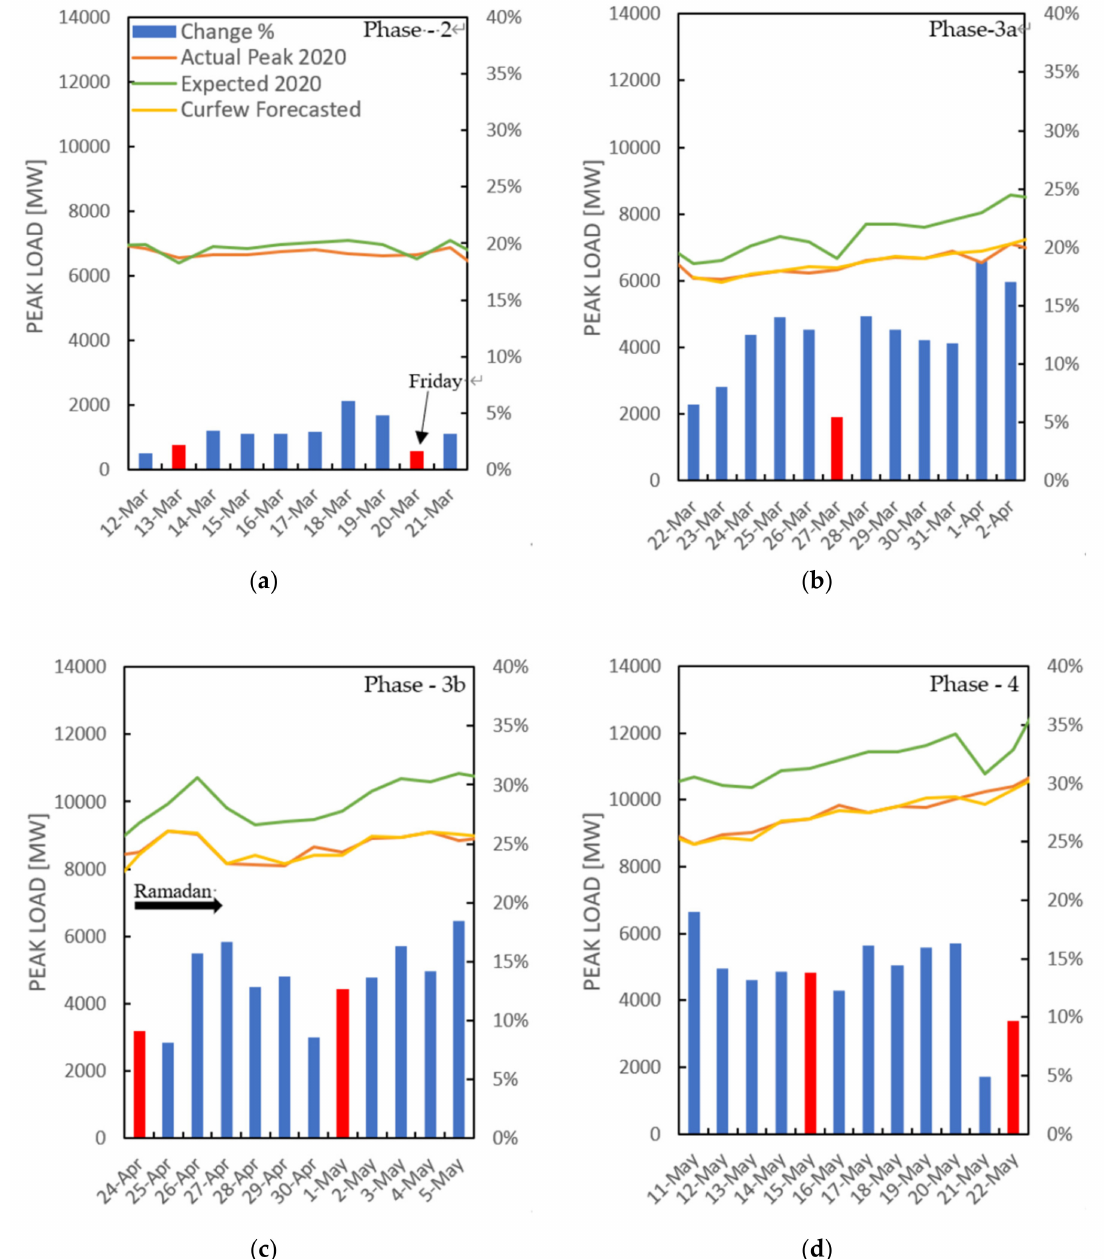
Figure 7. Change in peak load during four di ff erent phases of